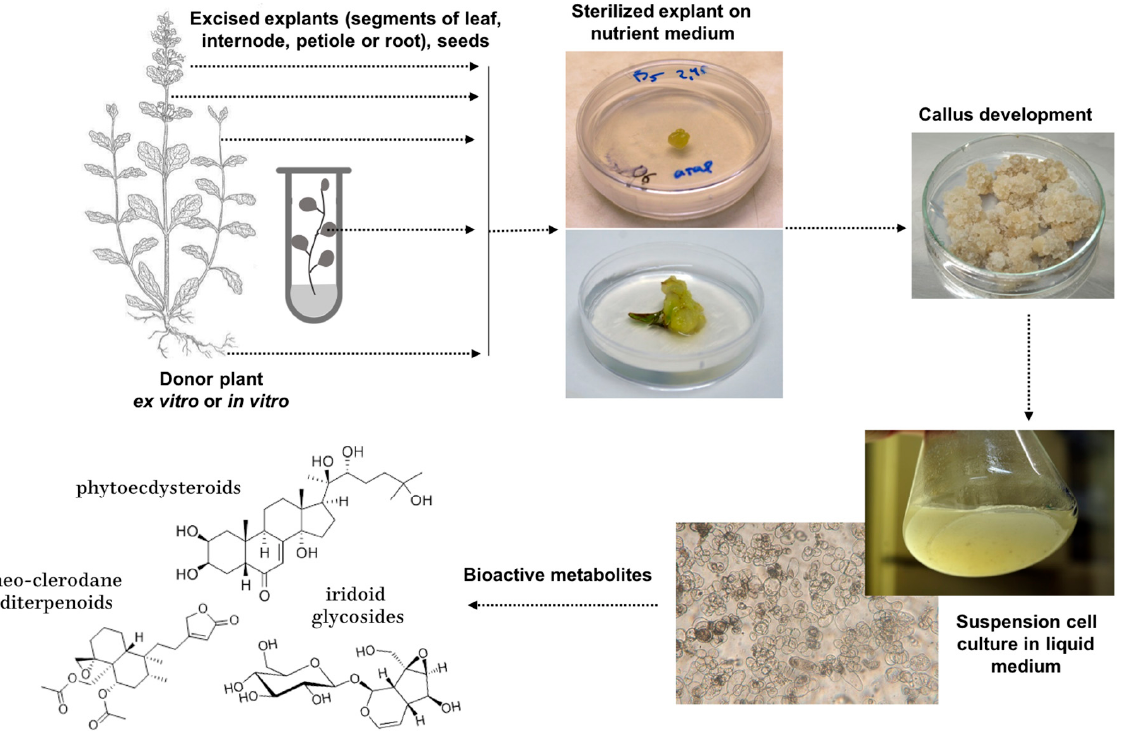
Figure 1. Schematic process of callus and suspension cell culture induction from the plant for the production of bioactive Ajuga components; phytoecdysteroids (20-hydroxyecdysone), neo-clerodane diterpenoids (ajugarin I), and iridoid glycosides (aucubin) are given as representative of their chemical classes. Photographs © IPPRAS. Ajuga plant drawing: Electronic Atlas of the Flora of British Columbia [eflora.bc.ca].